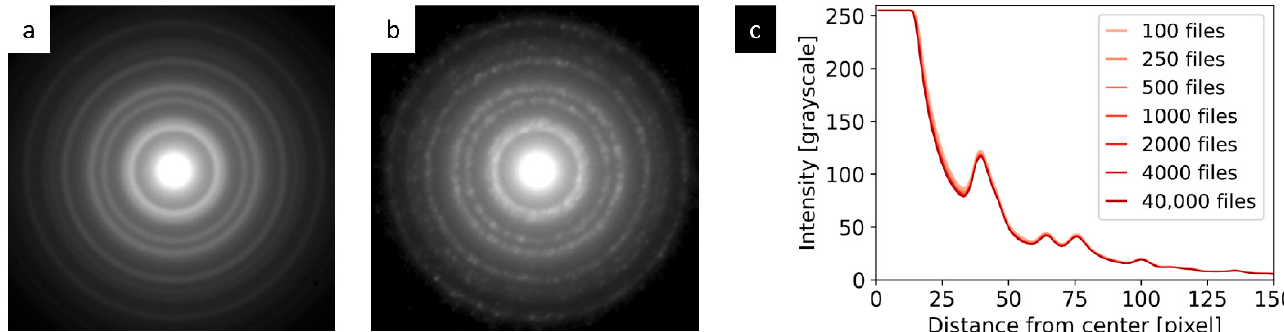
Figure 8. The influence of the dataset size on the quality of the final 4D-STEM/PNBD diffraction pattern of Au: ( a ) The initial 4D-STEM/PNBD diffraction pattern obtained by the summation of all 40,000 data files (i.e., full dataset Au big in Table 1), ( b ) the diffraction pattern obtained by the summation of just 100 files from the same dataset, and ( c ) the radial intensity profiles as a function of the dataset size. The contrast of the diffraction patterns ( a , b ) was increased for better visualization, while the radial profiles ( c ) show real intensities corresponding to unmodified images.